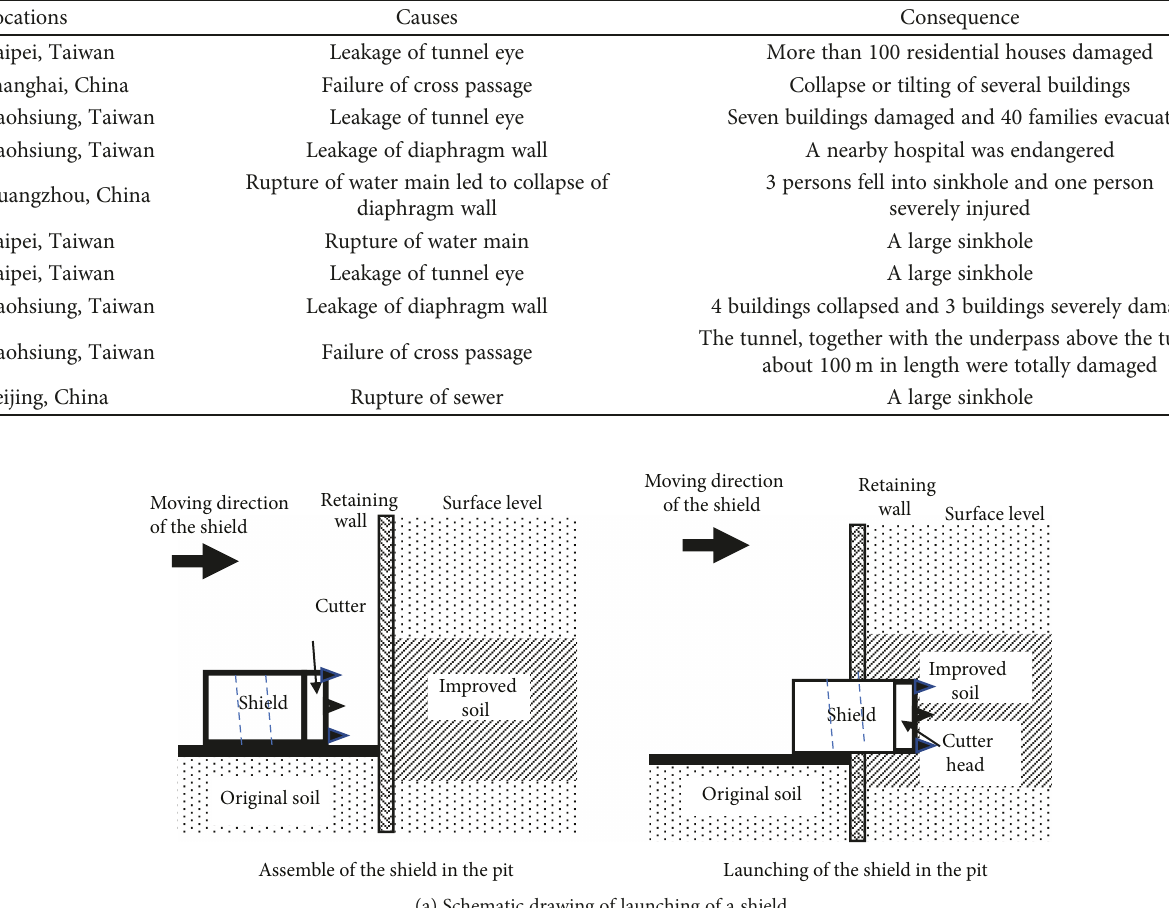
Table 1: Signi fi cant accidents in construction of underground metro system caused by groundwater in Asia Paci fi c region from 2001 to 2006.